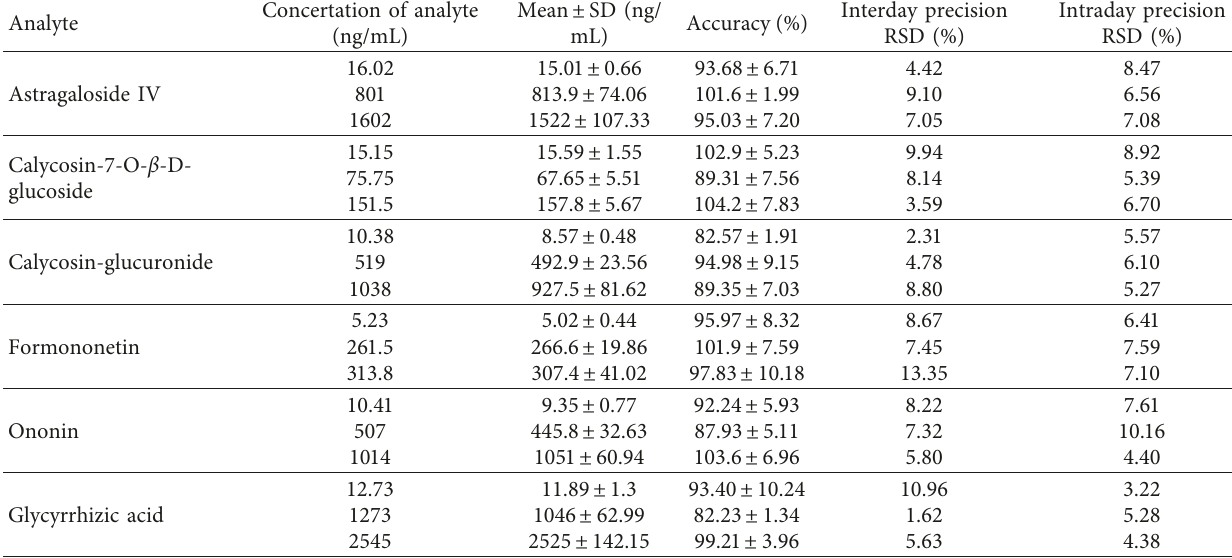
Table 3: Intra- and interday precision and accuracy of six analytes in mouse plasma ( x ± SD, n � 6).